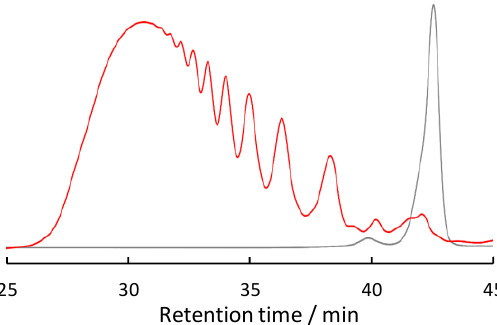
Figure 1. Gel-permeation chromatography (GPC) analysis of monomer 8 (gray line) and crude ins- SP-PPE (red line) after polymerization.